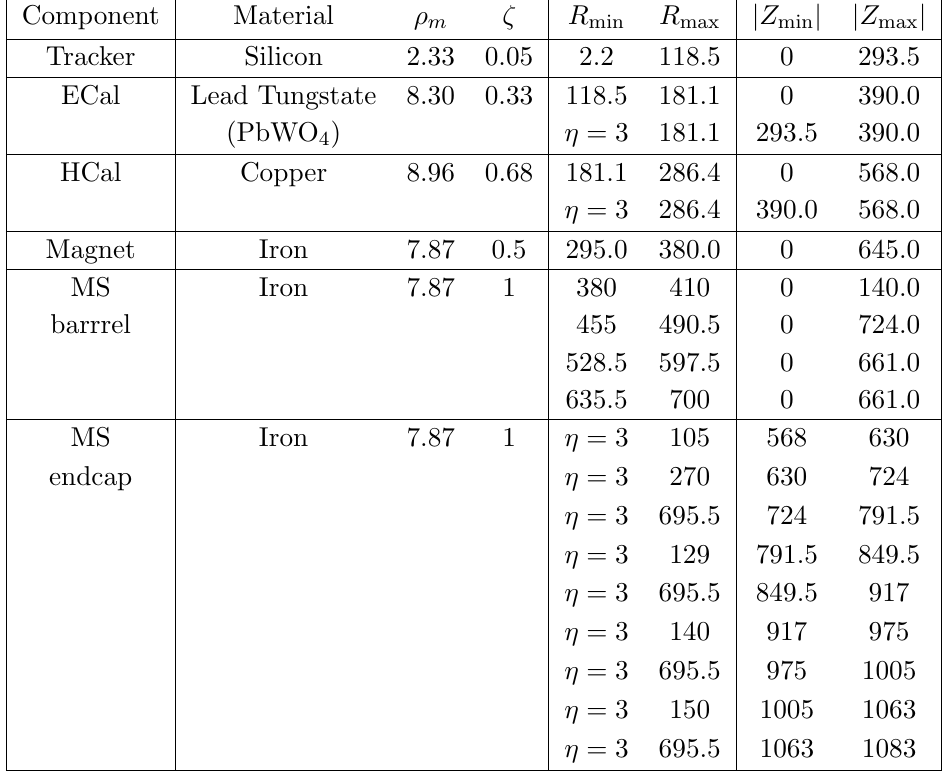
Table 1 . Details of the cylindrical CMS detector used in this study. (cid:26) m is in g/cm 3 , all R and Z dimensions are in cm. An R min value of (cid:17) = 3 implies that for a given value of Z , the inner radius is set where (cid:17) = 3. Outside of the beampipe vacuum, everywhere not mentioned in this table, notably the muon system drift chambers, is assumed to consist of air, (cid:26) air = 0 : 001165 g/cm 3 and (cid:16) = 1. region of the potential